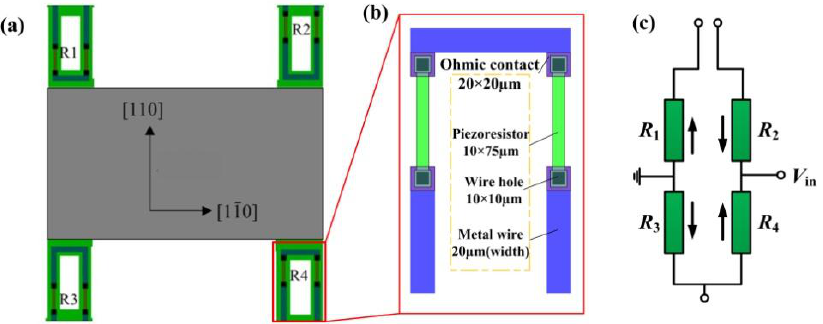
Figure 7. The piezoresistors in the sensor chip: ( a ) the configuration; ( b ) the dimensions; ( c ) the connection of piezoresistors in full Wheatstone bridge